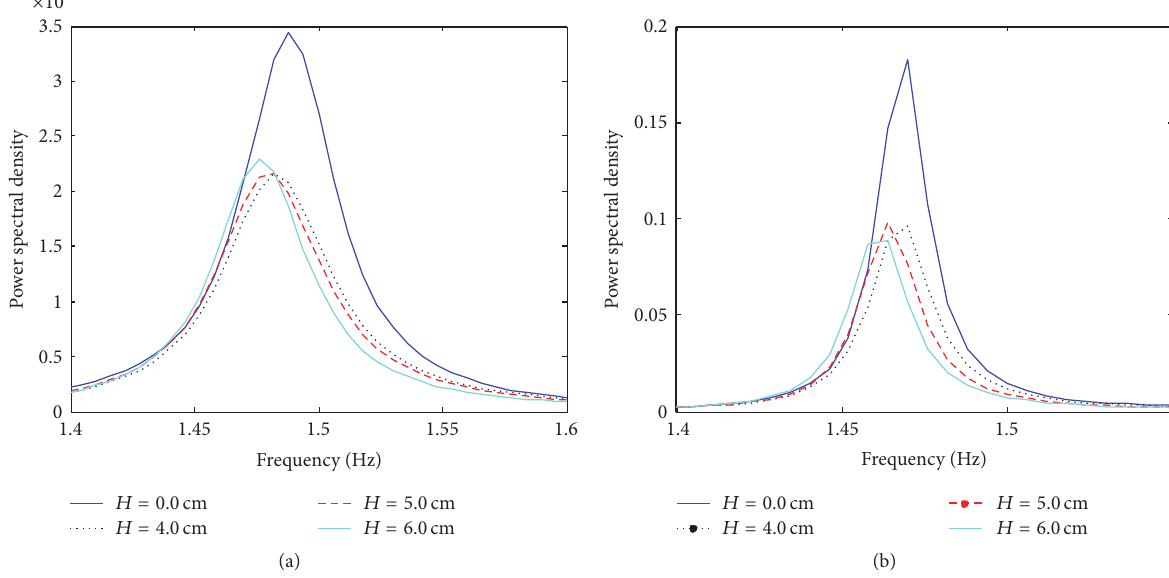
Figure 12: PSD values of displacement for the top floor of the structure when 𝛽 = 10 ∘ in both (a) x -direction and (b) y -direction.